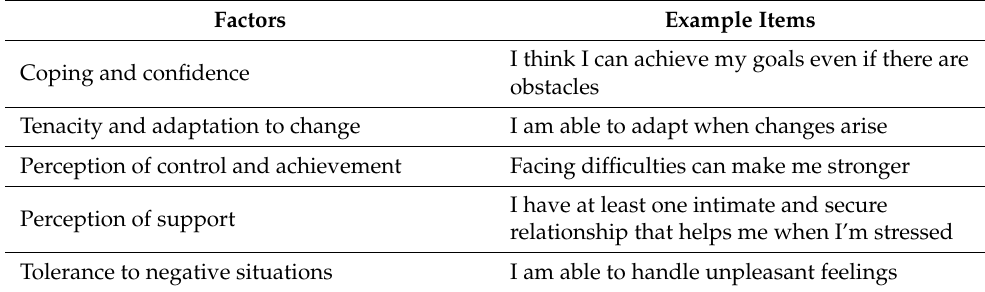
Table 2. Factors of the Connor Davison Resilience Scale (CD-RISC) scale.